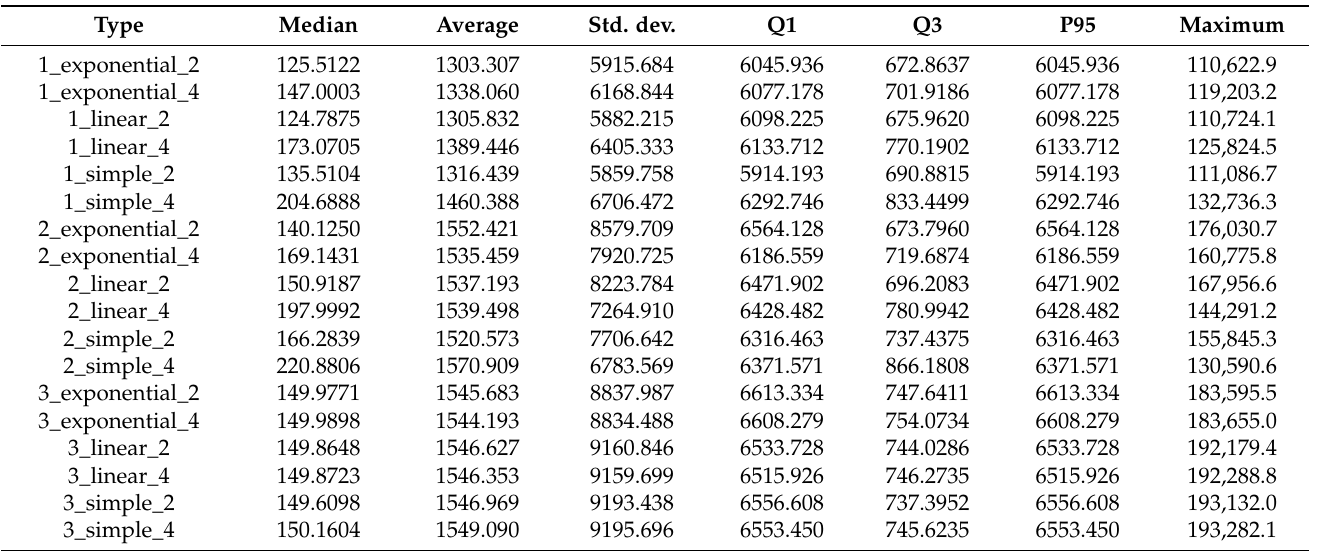
Table 6. MAE statistics for the second set of missing data